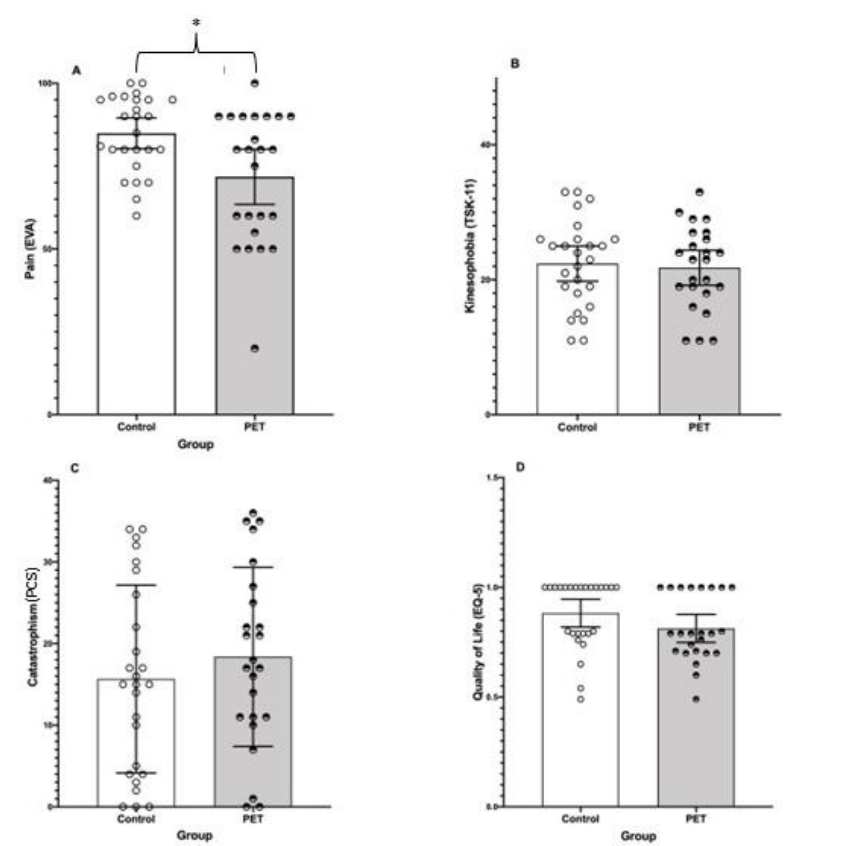
Figure 2. Mean and 95% confidence interval (CI 95% ) of PET and CG groups after the intervention period. White dots represent the individuals of the control group while the black dots represent those of the PET group. ( A – D ) graphs: show differences between groups on pain, kinesiophobia, catastrophizing and quality of life, respectively. * means p = 0.01.